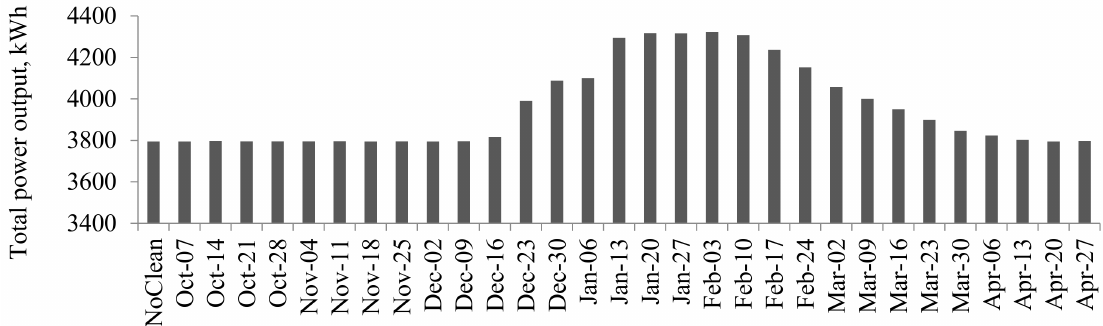
Figure 11. Cumulative heat while cleaning once during the heating